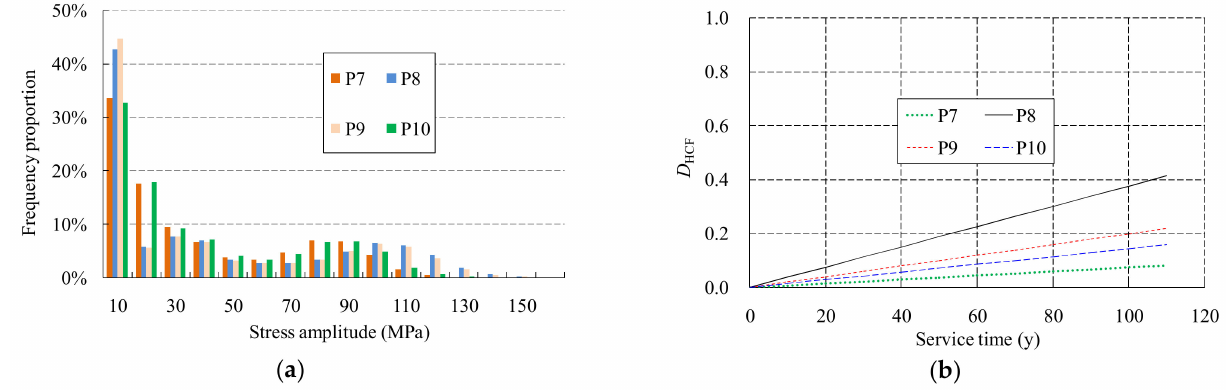
Figure 14. Stress spectrum and fatigue damages accumulated during service: ( a ) stress spectra of the joints; ( b ) HCF damages of the joints.